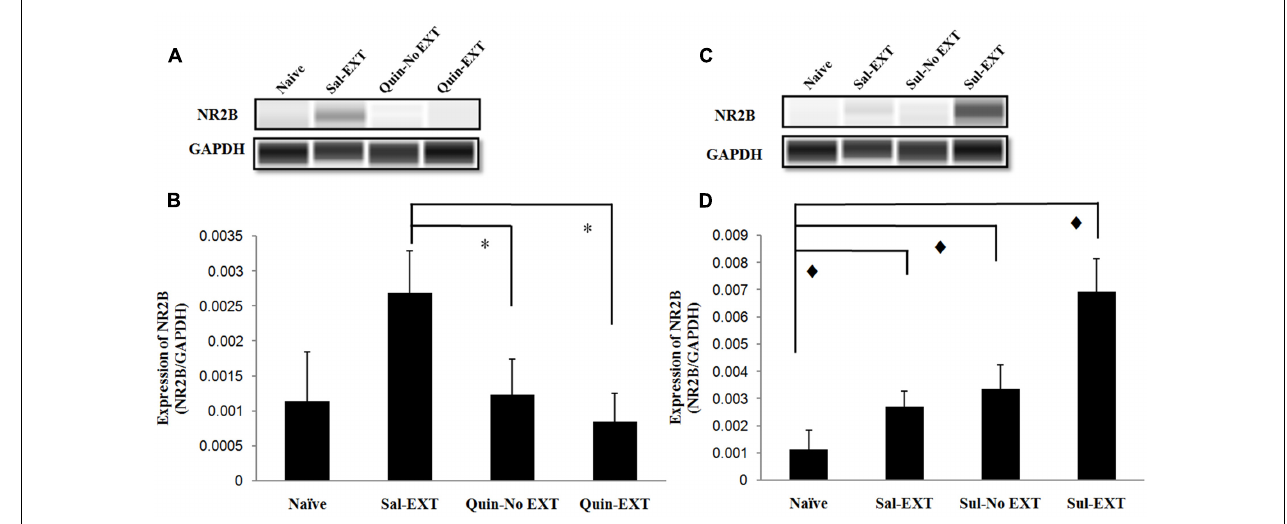
FIGURE 7 | The effect of infusion of quinpirole or sulpiride into the BLA before extinction training on NR2B expression levels after the LTM test. (A,B) Quinpirole rats showed decreased NR2B expression. ∗ P < 0.05 vs. the Sal-EXT group. (C,D) Sulpiride rats showed increased NR2B expression. (cid:7) P < 0.05 vs. the Sul-EXT group. n = 3 in each